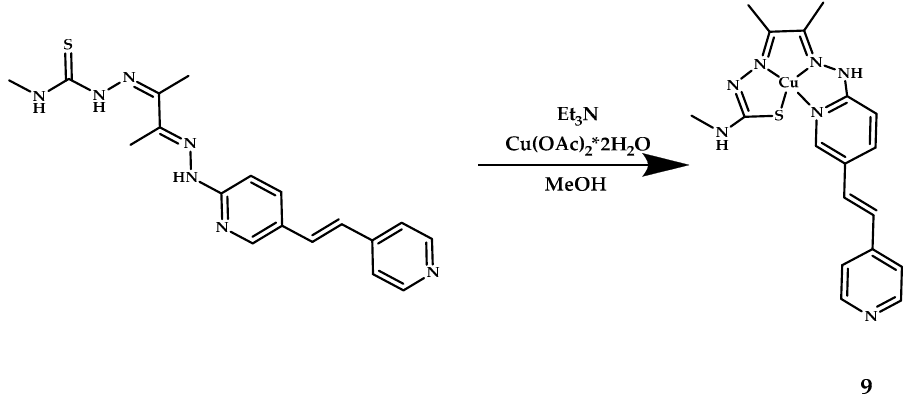
Figure 5. Cu(II)-ATSM derivative conjugated with piridylstilbene functional group 9 , designed for A β fibrils visualization.